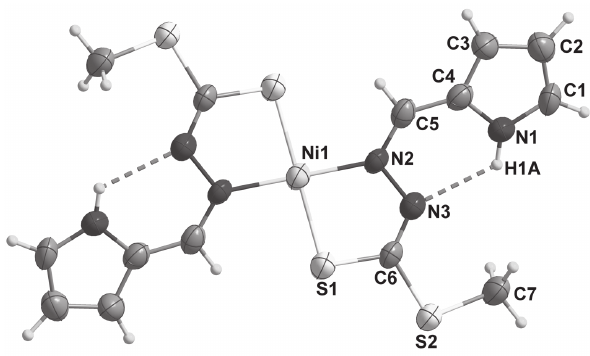
Table 1: Data collection and handling.